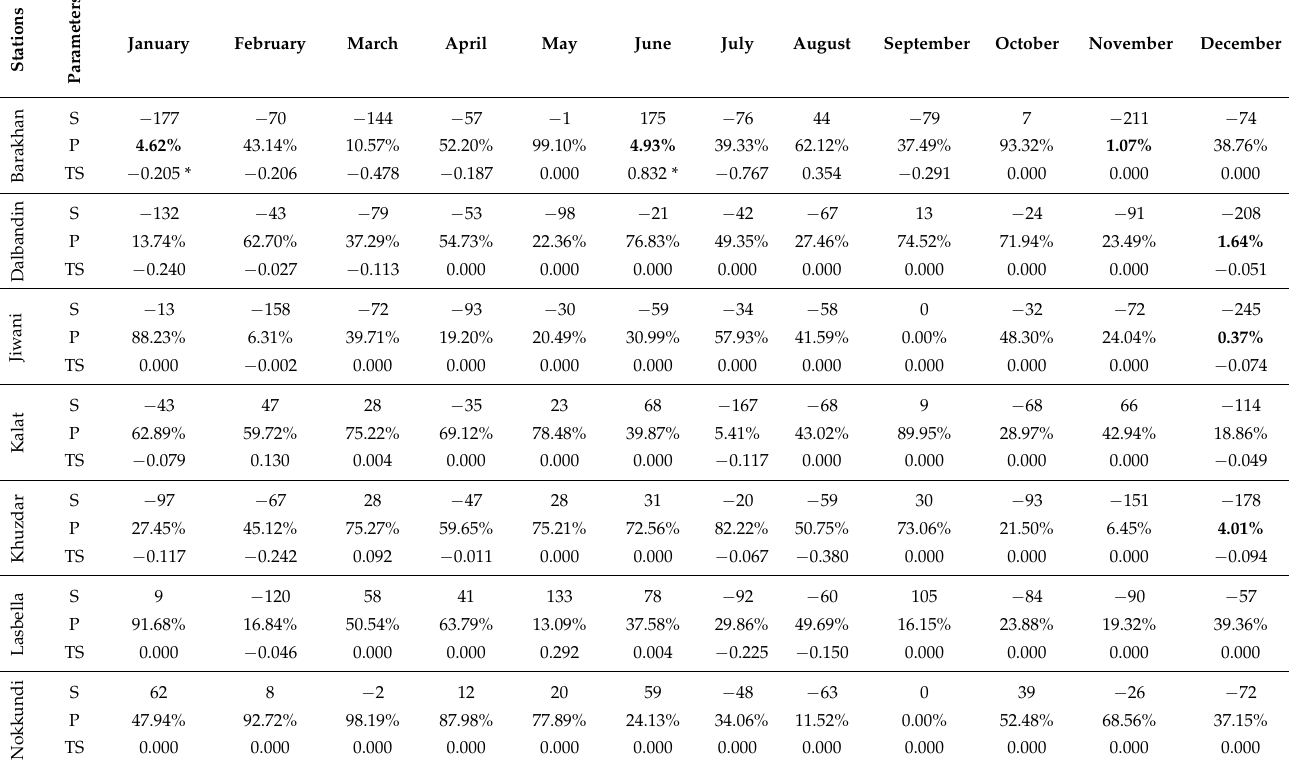
Table 2. Monthly significant increasing (decreasing) trends in precipitation—individual